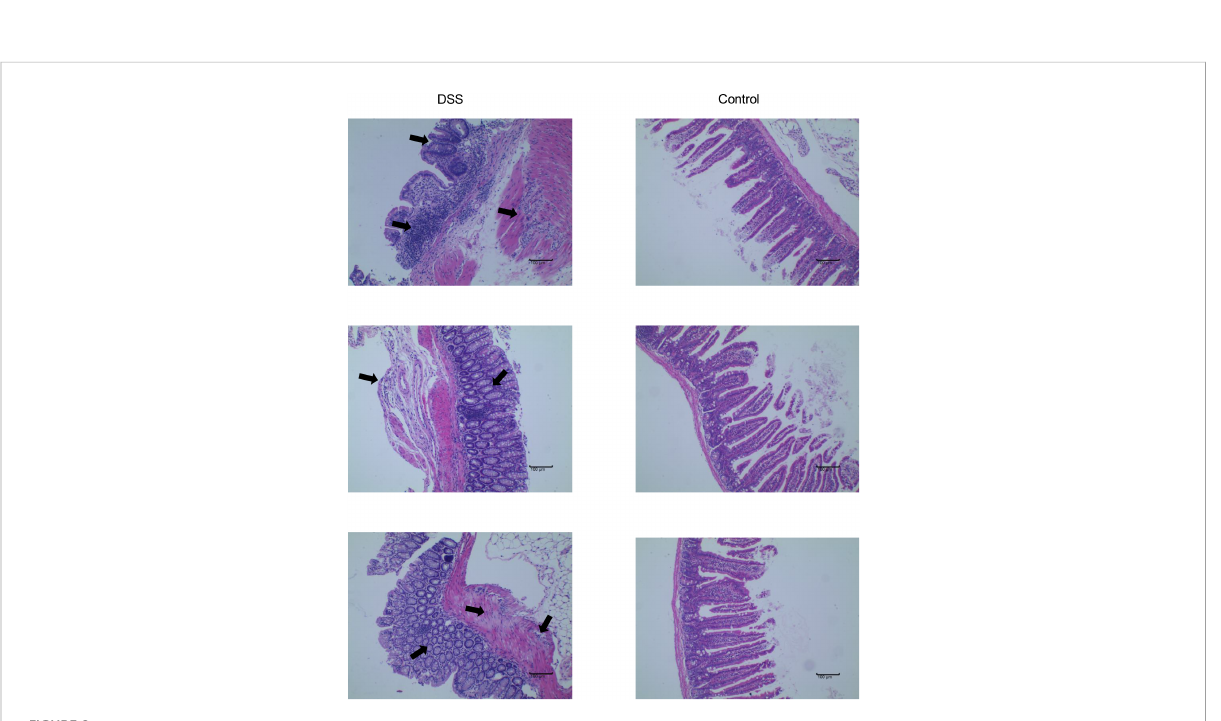
FIGURE 9 Comparison of HE staining between the DSS and control